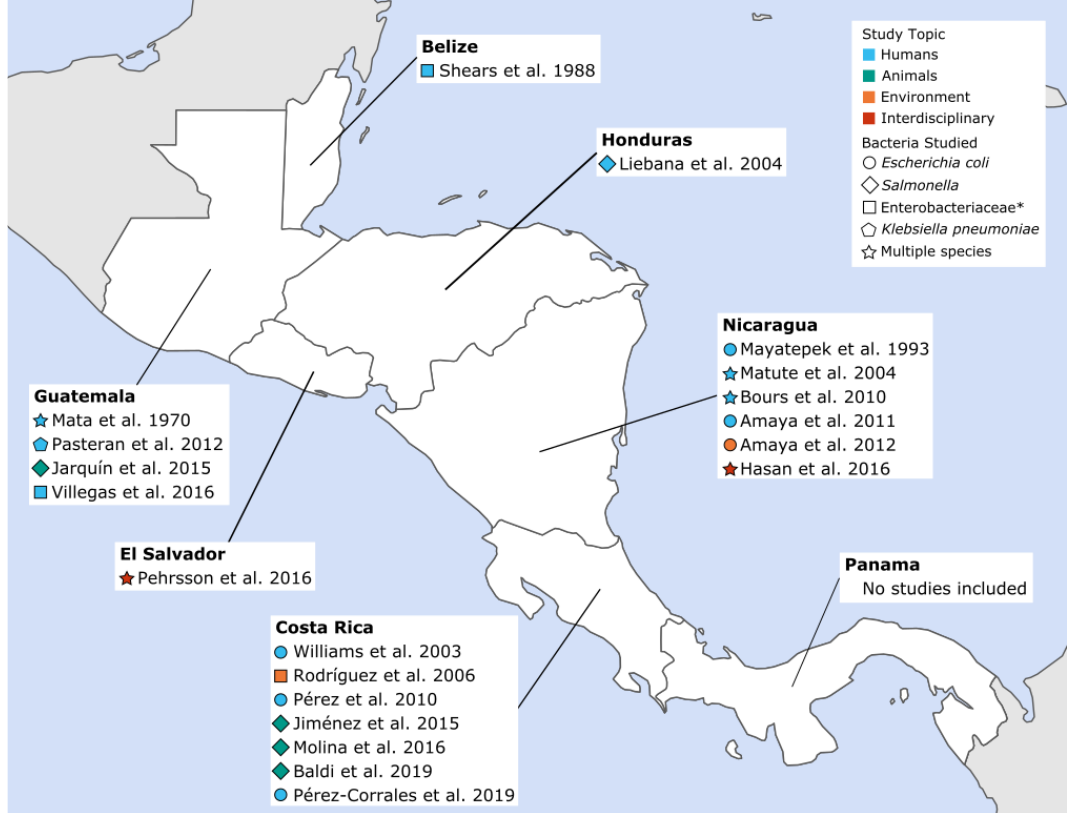
Figure 2. Community-acquired antimicrobial resistant Enterobacteriaceae (CA-ARE) studies included in the review by year, sample source and pathogen. * Bacterial species studied were not specifically defined beyond the family Enterobacteriaceae.